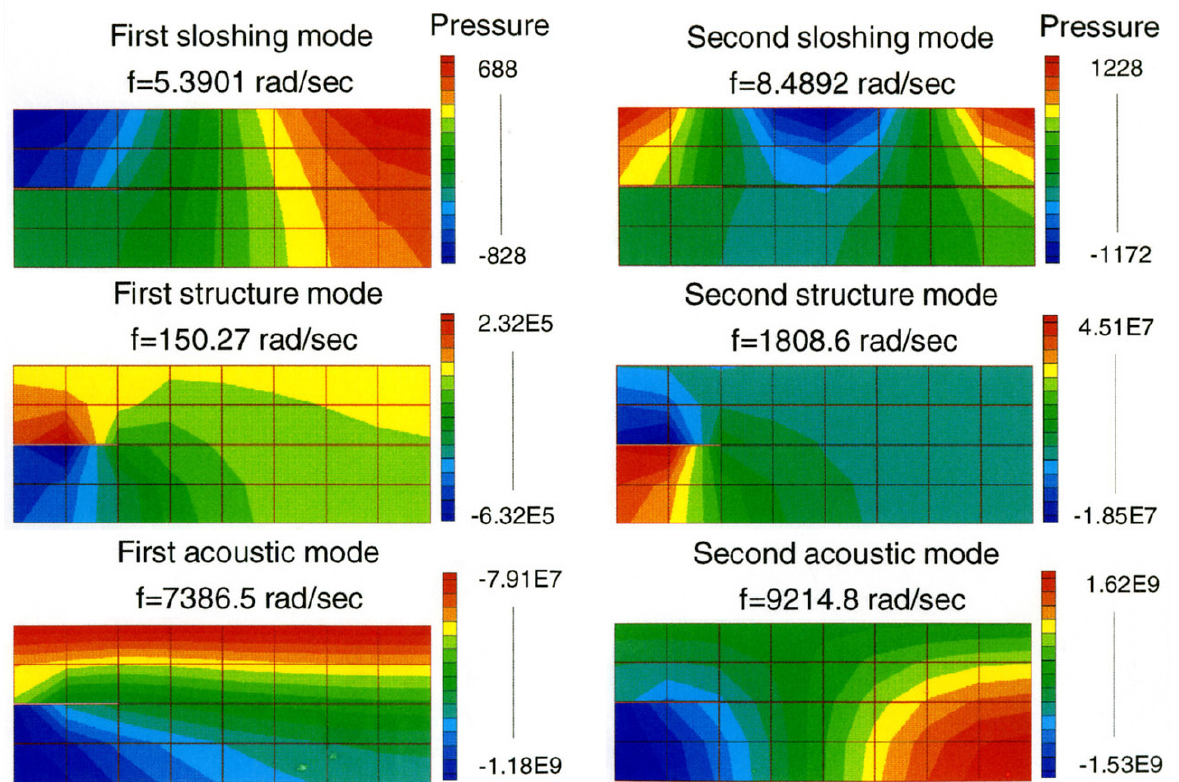
Figure 3. Pressure distribution of an acoustic fluid-solid interaction system (from the author’s earlier work